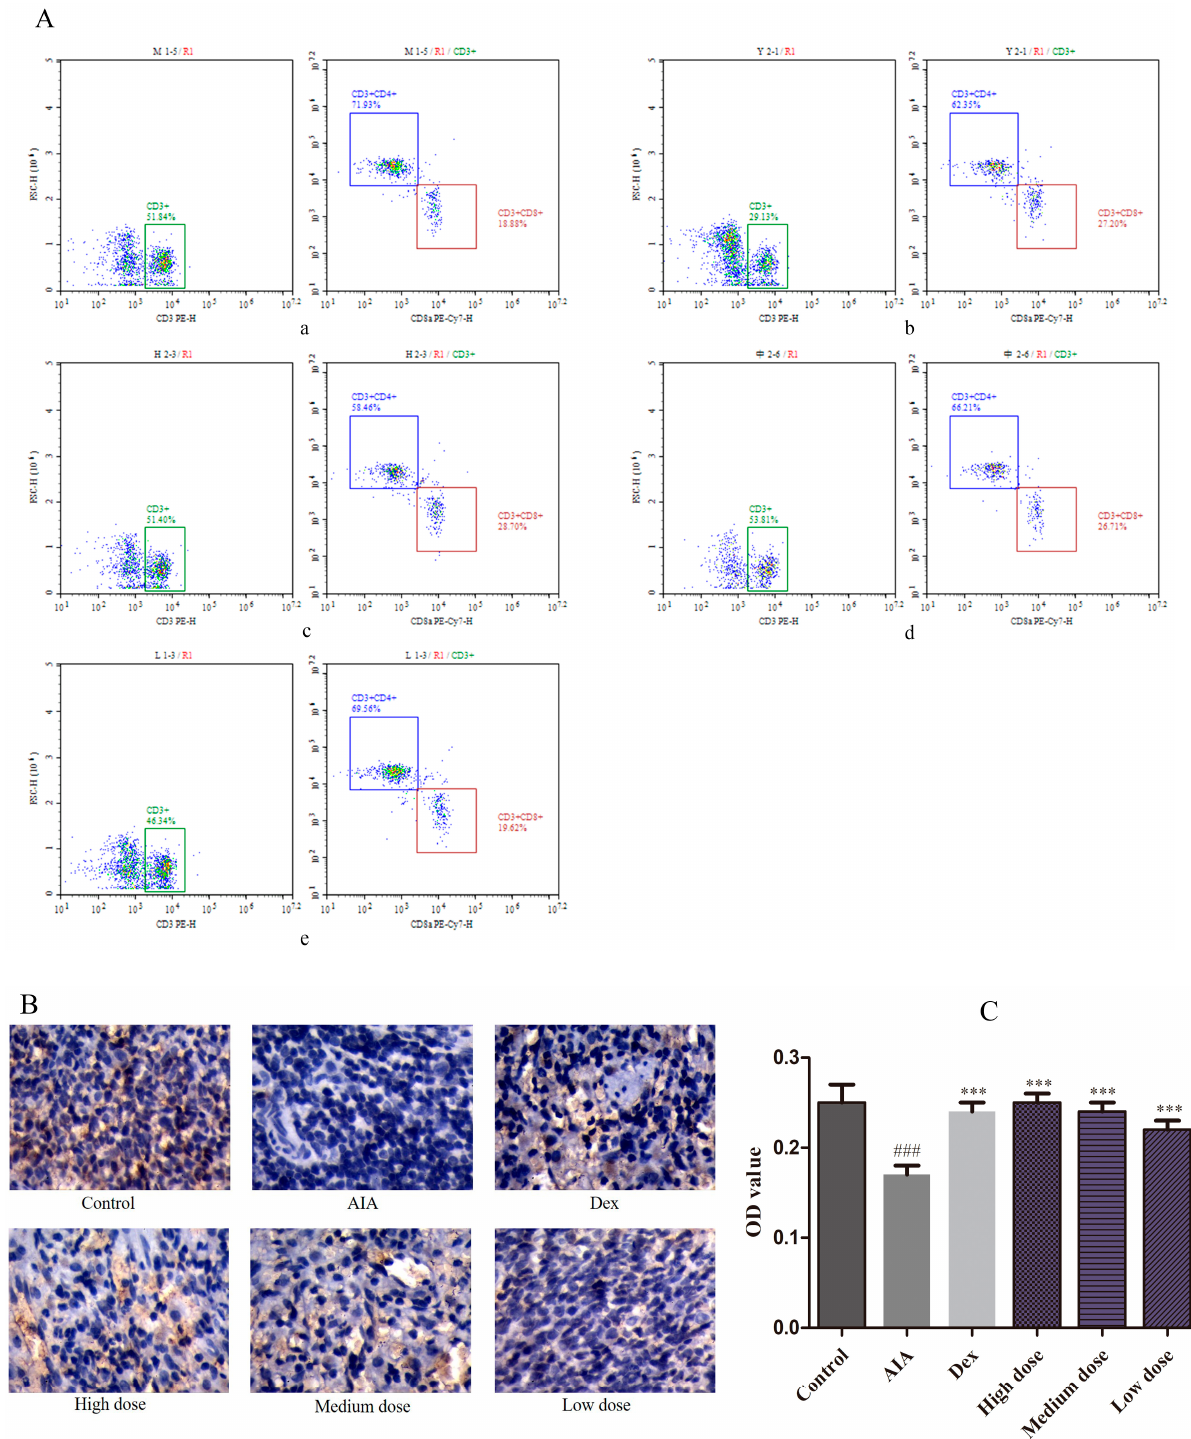
Figure 5. Effects of purpurin on CD4+ and CD8+ T cells, and FOXP3 contents. ( A ) The ratio of CD4+/CD8+ estimated using flow cytometry. ( a ) AIA group, ( b ) Dex group, ( c ) high-dose purpurin group, ( d ) medium-dose purpurin group, and ( e ) low-dose purpurin group. ( B ) Immunohistochemi- cal staining of FOXP3 in the spleen tissue of rats in each group (magnification: 100-fold). ( C ) The optical density (OD) value of each group. Dex: dexamethasone; AIA: adjuvant-induced arthritis; Data are represented as mean ± SD. ### p < 0.001 vs. control, *** p < 0.001 vs. model, n = 6 in each group. Table 1. The ratio of CD4+/CD8+ of rats. Group